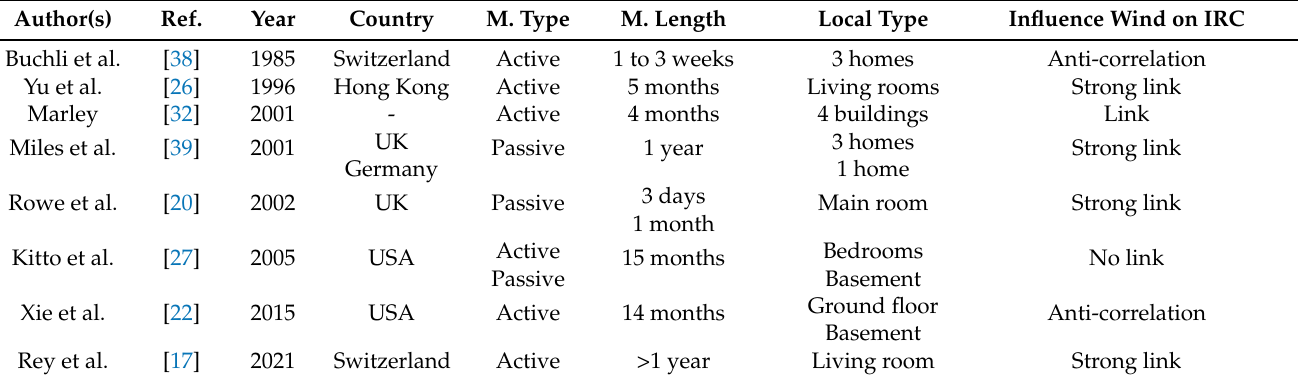
Table 5. Synthesis of wind events on IRC highlighted in a selected literature. (Ref.: references; M.: